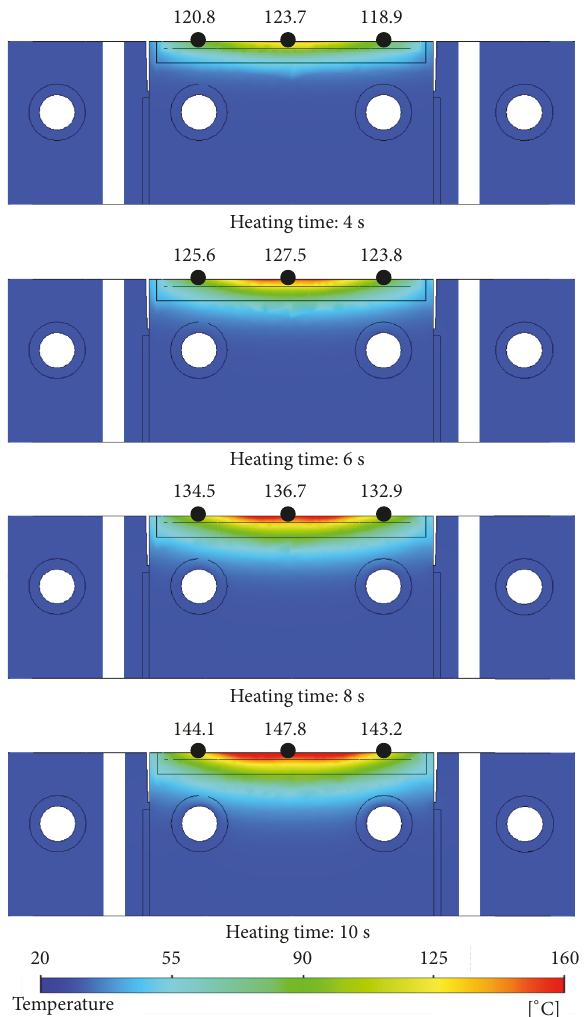
Figure 19: Temperature distribution at the cross section B-B with the thin rib